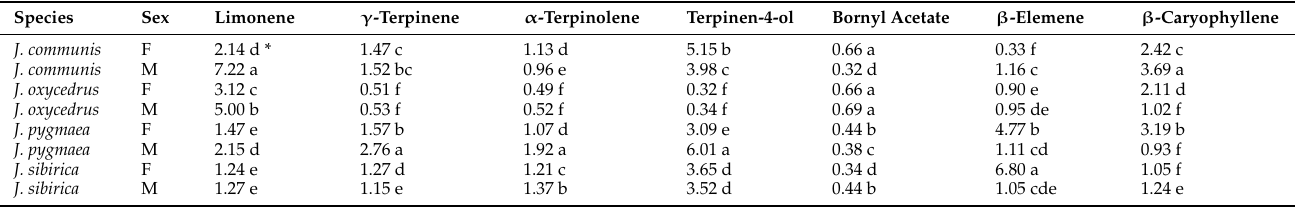
Table 3. Mean concentration (%) of limonene, γ -terpinene, α -terpinolene, terpinen-4-ol, bornyl acetate, β -elemene, and β -caryophyllene (extracted using the commercial steam extraction method) obtained from the eight combinations of species and sex.